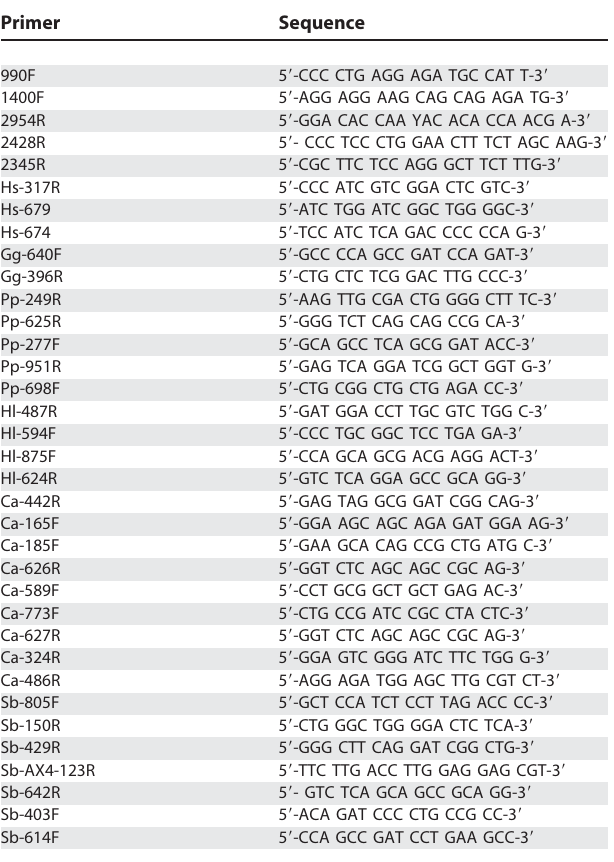
Species abbreviations as in Figure 1. DOI: 10.1371/journal.pgen.0010018.t004